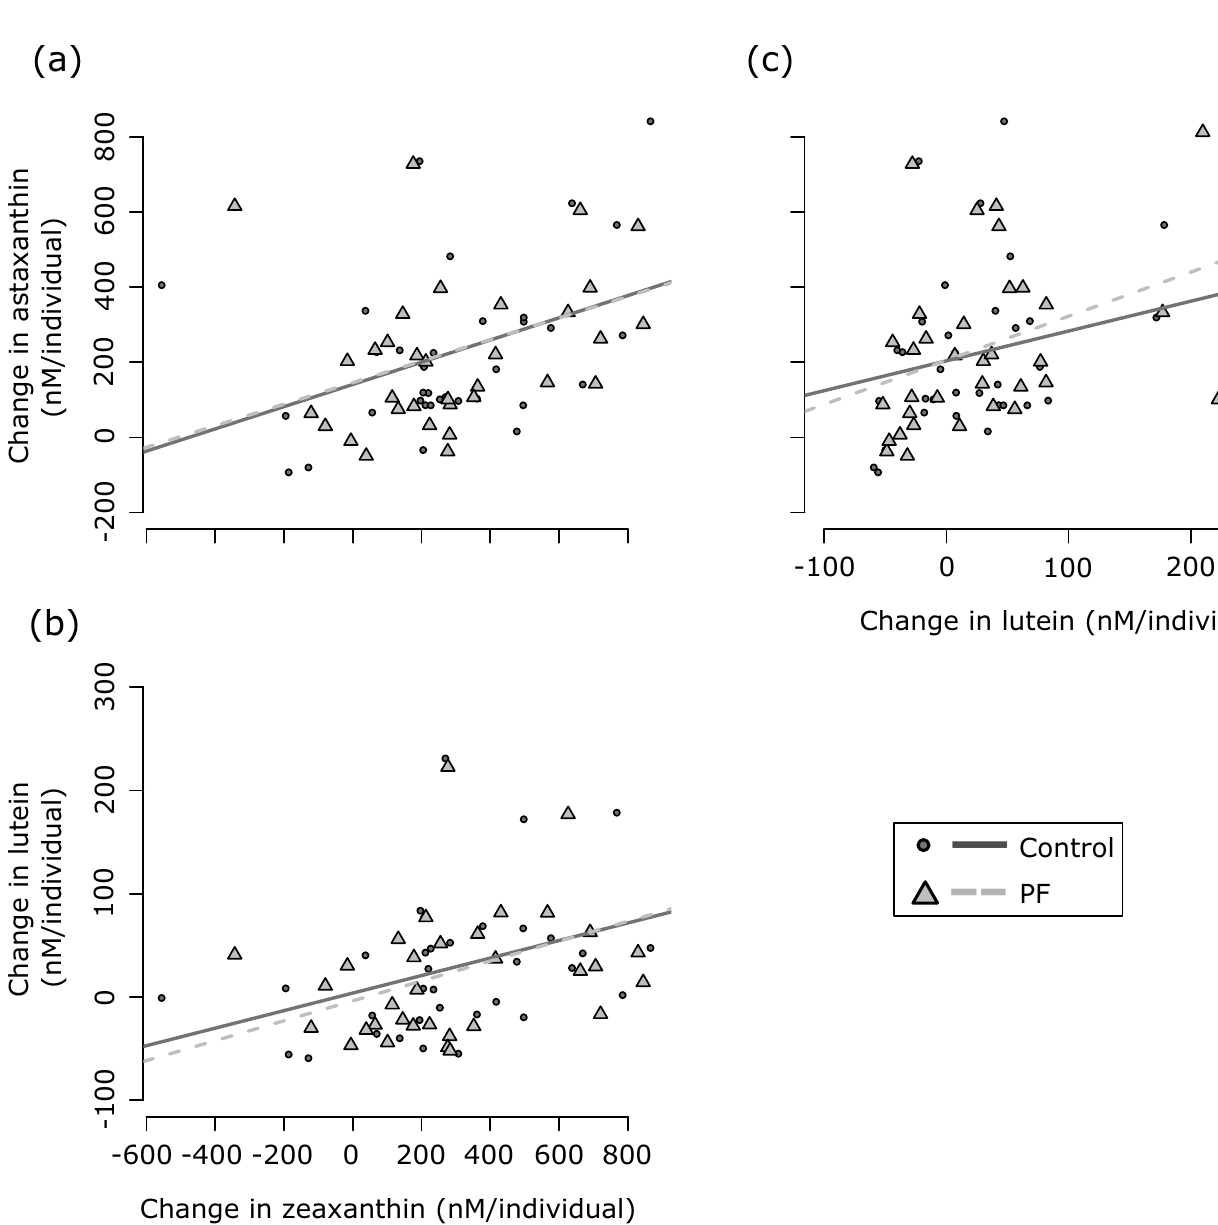
Fig 2. Change in carotenoid composition during embryo development. Panels represent the relationships between absolute change in (a) astaxanthin and zeaxanthin, (b) zeaxanthin and lutein, and (c) astaxanthin and lutein from fertilization to the late-eyed development stage in the sham-treated controls (circles and solid line) and in the P . fluorescens (PF) treated samples (triangles and dashed line). Absolute change in carotenoids was determined as the carotenoid content in eggs minus carotenoid content in embryos. See text for non-parametric statistics. The regressions lines are shown for illustration.